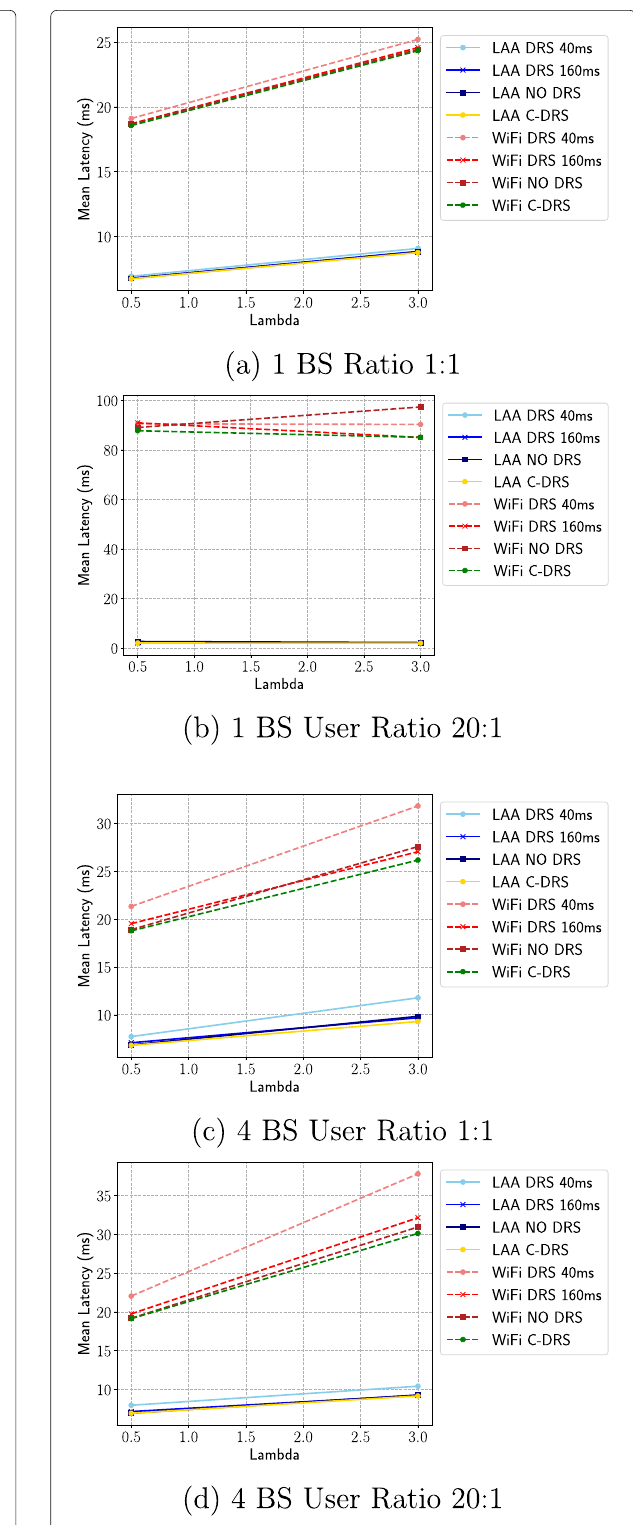
Fig. 10 Static scenario latency density results Fig. 11 Scenario density latency results (ped.